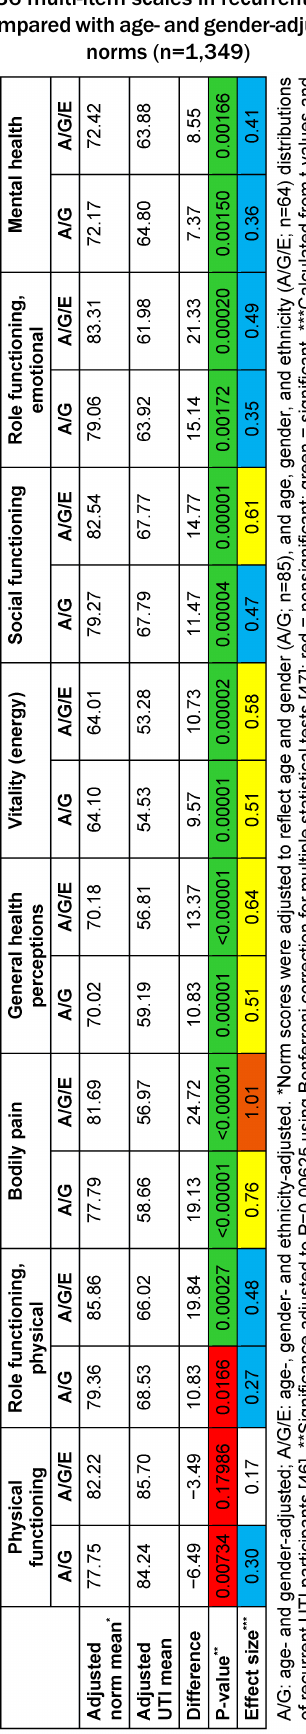
Table 2: SF-36 multi-item scales in recurrent UTI patients